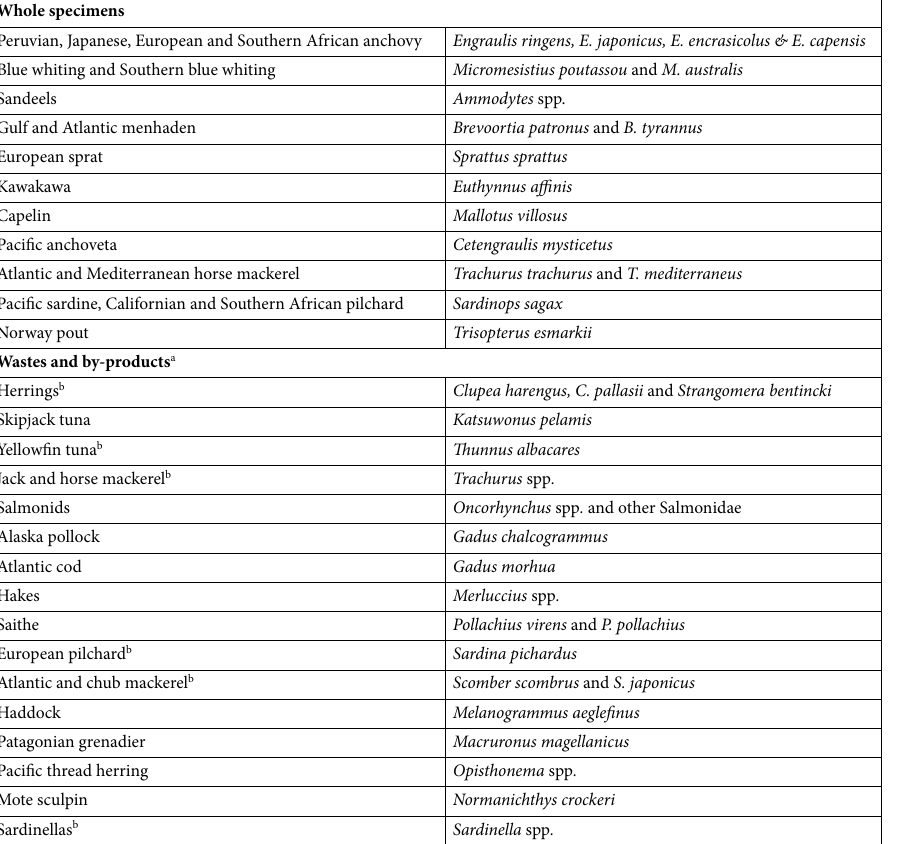
Table 1. Main marine fish species used in fishmeal production, divided into two categories: ‘whole specimens’ and ‘wastes and by-products’. Both categories in descending order of overall global catch rates 37,38 . Adapted from 32,33,36–38 . a By-products (e.g. offal) and other wastes from food processing industry, fisheries discards or excess from total allowable catch from prime food fish. b At least some of whole fish catch to fishmeal